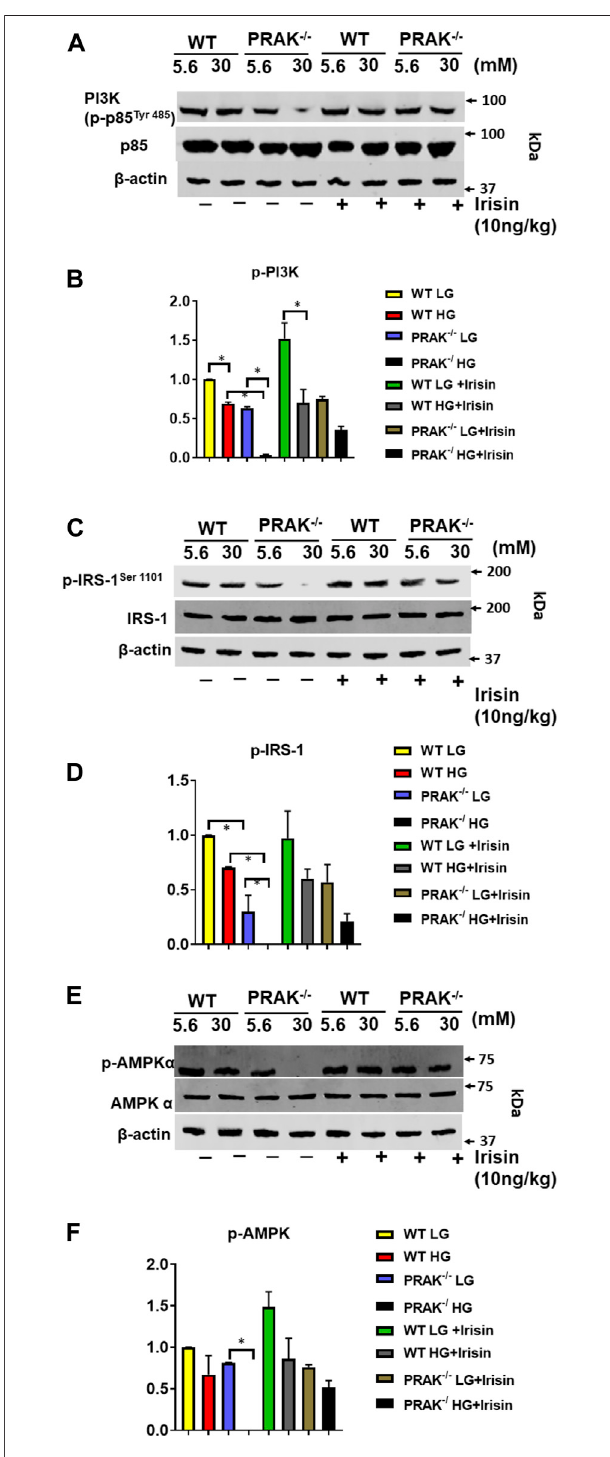
FIGURE 5 | Tyr 485) and non-phosphorylated PI3 Kinase; (B) Bar graph (lower panel) represents ratios of PI3 Kinase (p85 at Tyr 485) against non- phosphorylated PI3 Kinase from densitometric analysis ( n (cid:2) 3/per group); (C) : Representative blot of phosphorylated IRS-1 and non-phosphorylated IRS-1; (D) Bar graph (lower panel) represents ratios of phosphorylated IRS-1 FIGURE 5 | Deletion of PRAK suppresses insulin signaling in C2C12 against non-phosphorylated IRS-1 from densitometric analysis ( n (cid:2) 3/per myoblasts exposed to high glucose. (A) PRAK − / − and wild type cells were group); (E) Representative blot of phosphorylated AMPK α and non- cultured under the indicated conditions for 48 h in either normal glucose or phosphorylated AMPK α ; Bar graph (lower panel) represents ratios of high glucose concentrations. Cell lysates underwent western blotting phosphorylated AMPK α against non-phosphorylated AMPK α from densito- using anti phospho ( p ) and total (t), PI3 Kinase (p85 at Tyr 485) (A,B) , or IRS-1 metric analysis. Values represent means ± SE ( n (cid:2) 3 samples/per group). (C,D) AMPK α (E,F) antibodies. (A) Representative blot of PI3 Kinase (p85 at * p < ( Continued )